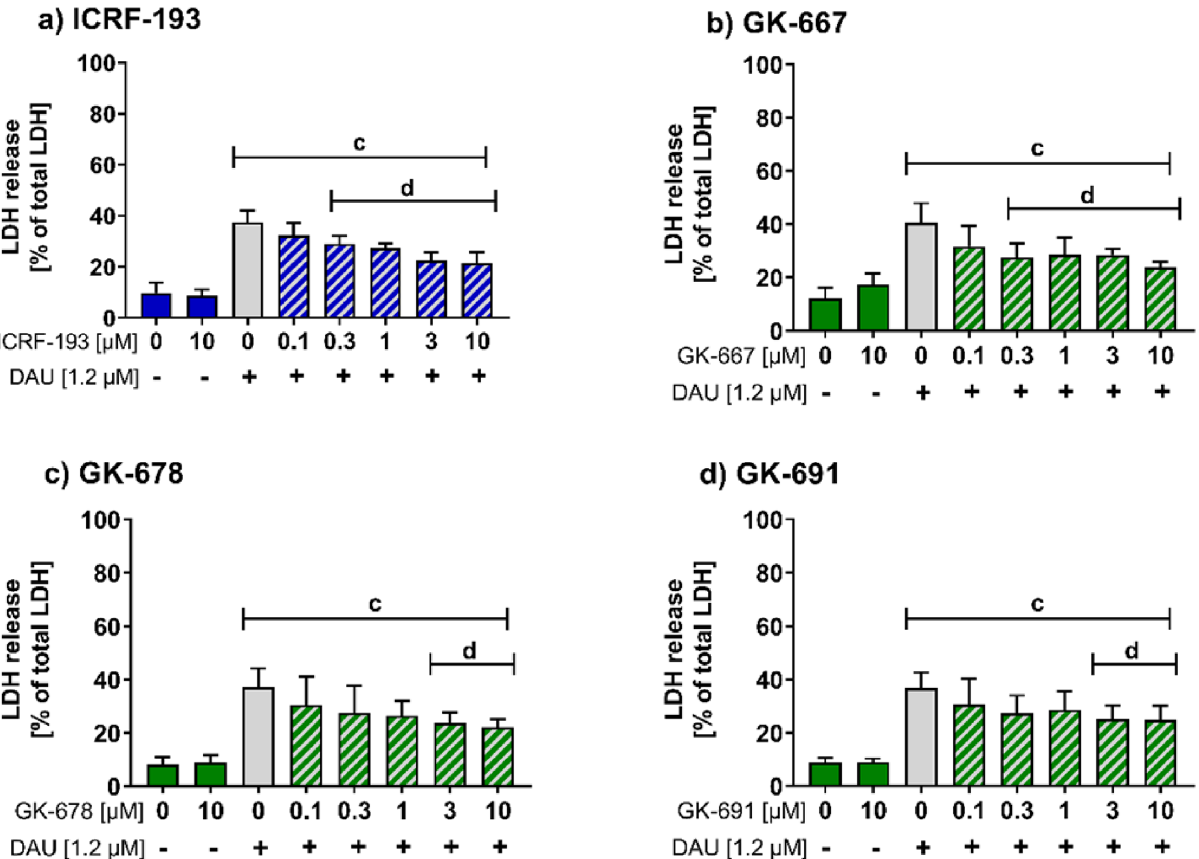
Figure 3. Cytoprotective effects of ICRF-193 and the prodrugs against anthracycline induced toxicity in neonatal ventricular cardiomyocytes. Neonatal ventricular cardiomyocytes were pre-incubated with ( a ) ICRF- 193, ( b ) GK-667, ( c ) GK-678 or ( d ) GK-691 for 3 h, then DAU was added for another 3 h incubation followed by a 45 h period in medium without DAU or prodrug. The cytotoxicity was determined spectrophotometrically as lactate dehydrogenase (LDH) release in culture medium. Data are presented as the mean +/− SD of four independent experiments. Statistical significance was evaluated using one-way ANOVA and Holm-Sidak’s post- hoc test; c—compared to control, d—compared to DAU; P ≤